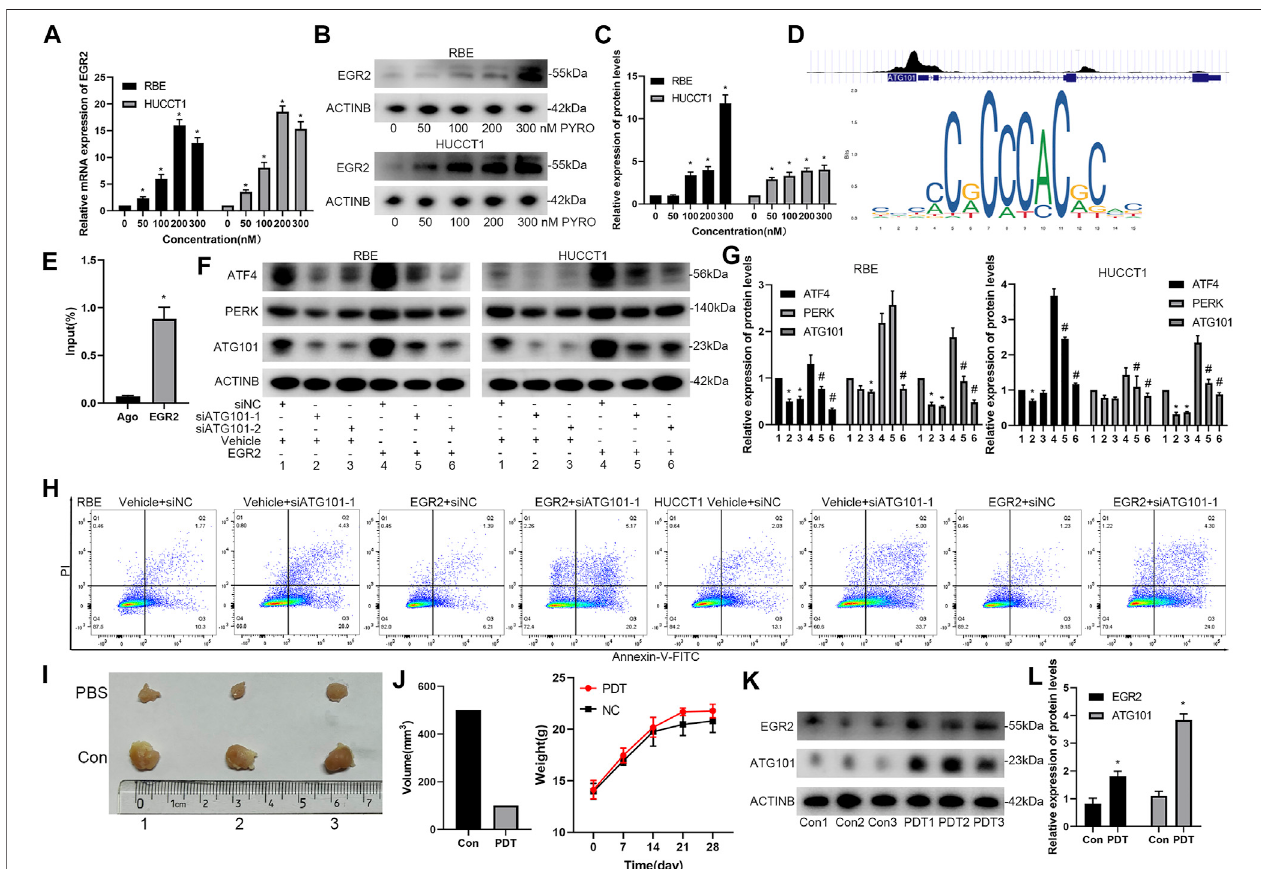
FIGURE10| EGR2 regulates theexpression ofATG101 and apoptosis rateafter PYRO-PDT treatment. (A) Through theCistrome tool in UCSCgenomebrowser, the binding peak of EGR2 and ATG101 promoter were shown in (i); a sequence matrix of EGR2 binding to AT101 promoter was shown in JASPAR database (ii). (B,C) After processing RBE and HUCCT1 cell lines in 6-well plates with different concentrations of PYRO-PDT for 4 h, the mRNA and protein levels of EGR2 were determined byqRT-PCTorWesternblot. (D) isahistogramoftherelativeexpressionofproteinsineachgroupin (C) . (E) TheRBEandHUCCT1celllinesoverexpressingEGR2 were constructed by lentivirus, and then transfected by siNC, siATG101-1, siATG101-2, respectively. The expression of ATF4, PERK and ATG101 were detected by westernblotafter48 hoftransfection. (F) isahistogramoftheexpressionofproteinsineachgroupin (E) .*Comparedwithgroup1; # comparedwithgroup4. (G) ChIP- qPCR assays were performed to fi nd the EGR2 required for binding of the ATG101 promoter. Ago: Agarose group; EGR2: Anti-EGR2 group. (H) The apoptosis rate in different levels of EGR2 and ATG101 in RBE and HUCCT1 cell lines was assessed by Annexin-V-FITC/PI staining and fl ow cytometry. (I) Cholangiocarcinoma subcutaneouslyxenograftmodelwasusedtoevaluatetheeffectofPYRO-PDTgroupandPBS(Con)controlgroupontumors.RBEcells(2.5*107/ml,200 ul/each)were injected intotheleft groin ofnude mice.After12 days, wecalculated thetumor sizeevery3 days.Whenthetumor sizereached 1 cm 3 , themice weresacri fi ced, and the tumors were removed for further detection. (J) is the statistical graphs of tumor volume and body weight in PDT and Con groups, respectively. (K) After the tumor was taken out, western blot was used to detect the effect of PDT treatment on the changes of EGR2 and ATG101. (L) is a histogram of the expression of proteins in each group in (K) . *, # p <